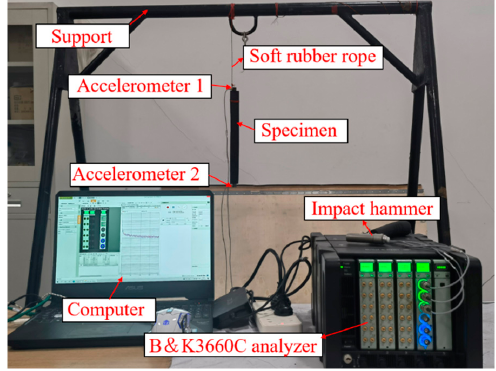
Figure 10. Band gap testing method.